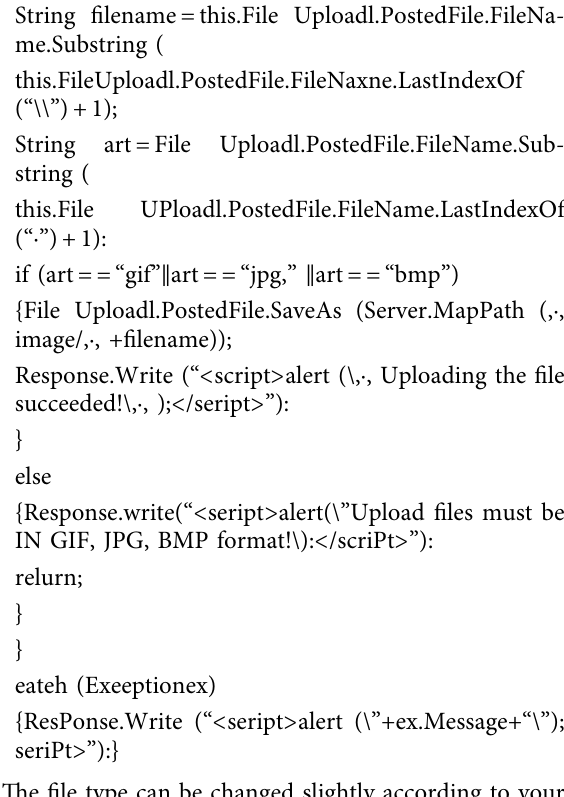
Figure 4: System administrator use case